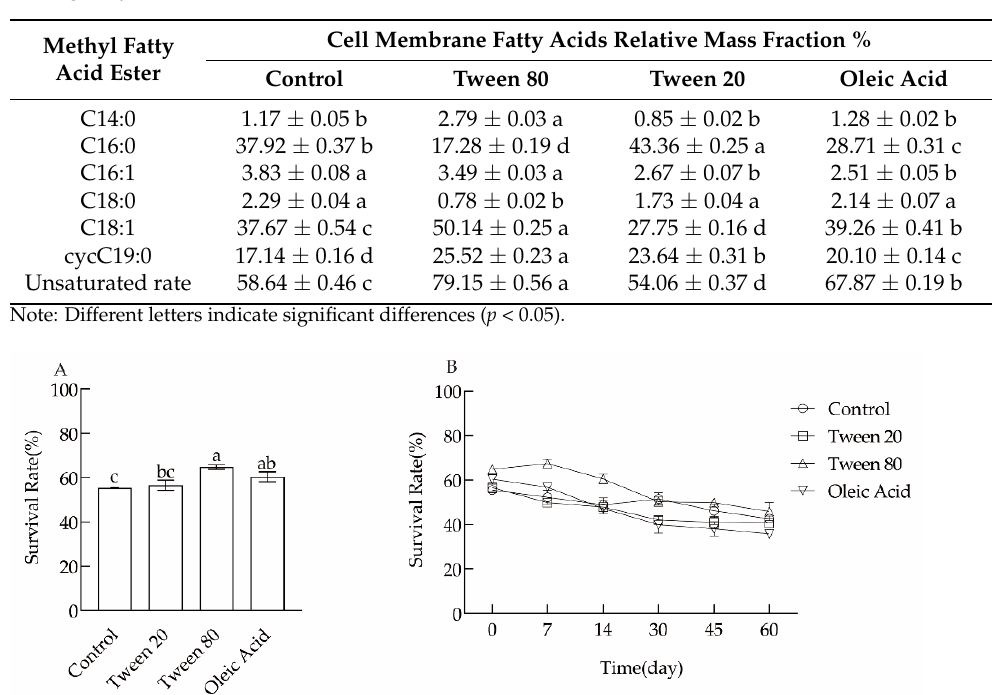
Table 4. The composition and relative content of cell membrane fatty acids of L. plantarum N8 after adding fatty acids and Tween.